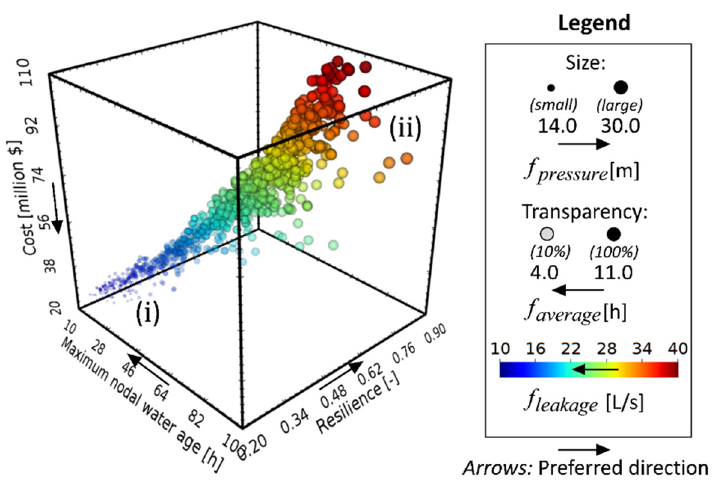
Figure 2. Global view of the six-objective Pareto-optimal solution set, with arrows pointing in the direction of preference.